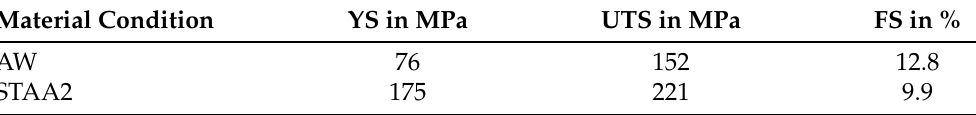
Table 6. The median values of YS, UTS and FS for the transversal tensile specimens. Material